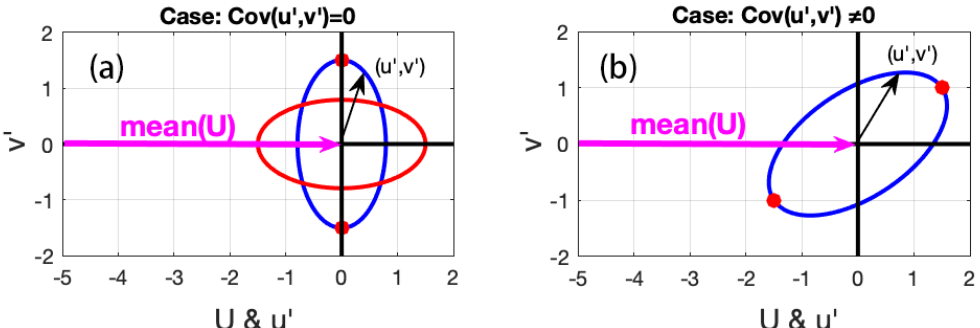
Figure 1. Graphical representation of two cases: 𝑐𝑜𝑣(𝑢 (cid:4593) , 𝑣 (cid:4593) ) = 0 ( a ) and 𝑐𝑜𝑣(𝑢 (cid:4593) ,𝑣 (cid:4593) ) ≠ 0 ( b ). The pink vector represents the mean wind speed (along x). The red or blue ellipse represents how the observations of 𝑢 (cid:4593) ,𝑣′ can be distributed. The black arrows represent possible individual observations of wind fluctuation. The red dots mark the ends of the long axis of the ellipse.